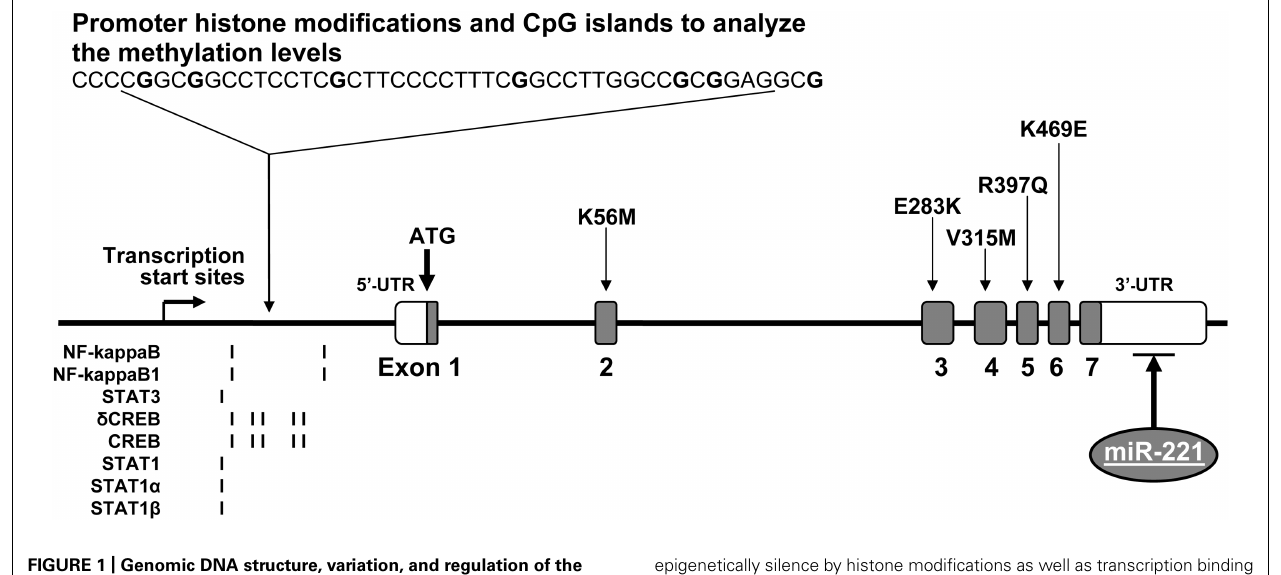
FIGURE 1 | Genomic DNA structure, variation, and regulation of the ICAM1 gene. The ICAM1 gene is consisted of seven exons and six introns. There are several non-synonymous SNPs, which reside one each in exons 2–6. In the gene promoter, there are CpG islands for methylation and